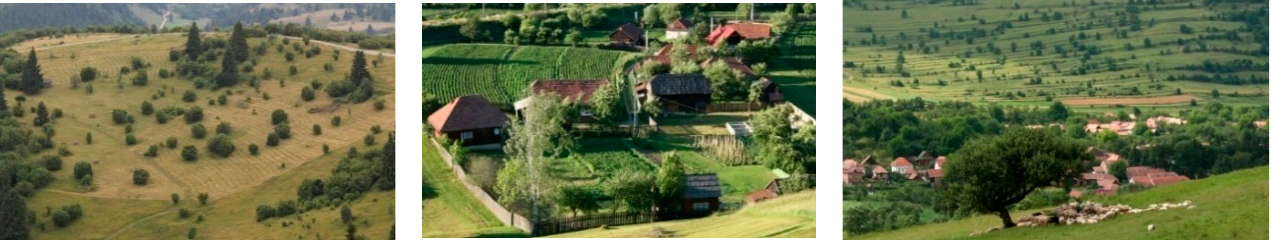
Figure 9. Example illustrations from Corine Land Cover nomenclature guidelines [33,34] for some mixed land covers appearing in the temperate site. Photographies by György Büttner (231) and Barbara Kosztra (242, 243). Copyright: European Environment Agency.